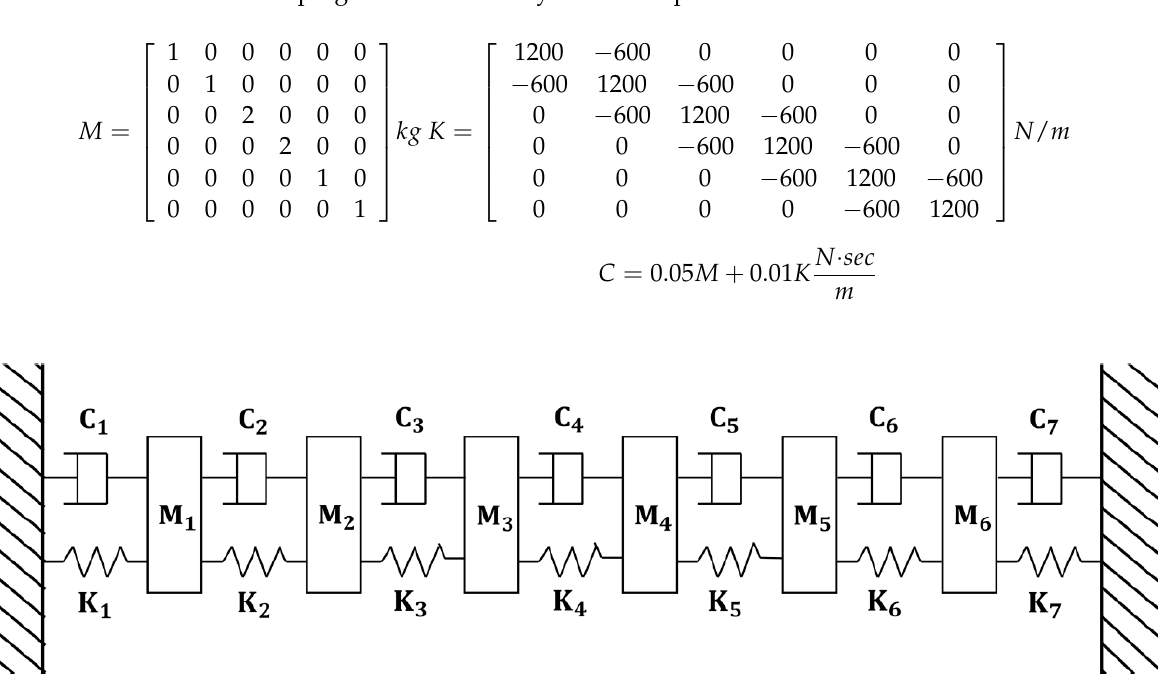
Figure 8. Six-DOF chain model with heavy damping.